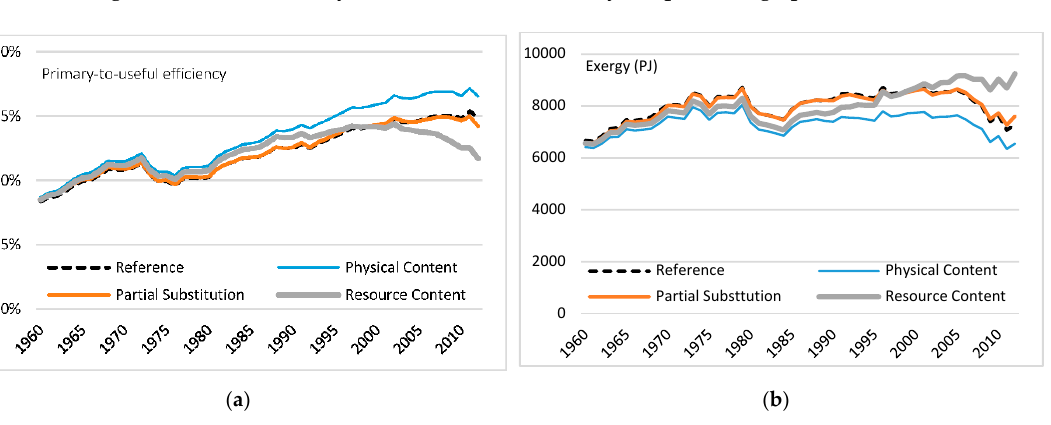
Figure 12. Results under high renewables scenarios; national ( a ) primary-to-useful exergy efficiency and ( b ) primary exergy consumption. “Reference” line shows results when not using a high-renewables scenario (i.e., electricity inputs are calculated using historical shares), with physical content method.